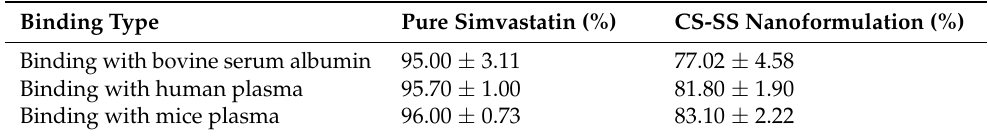
Table 2. Percentage of plasma protein binding of pure simvastatin and CS-SS nanoformulation. Binding